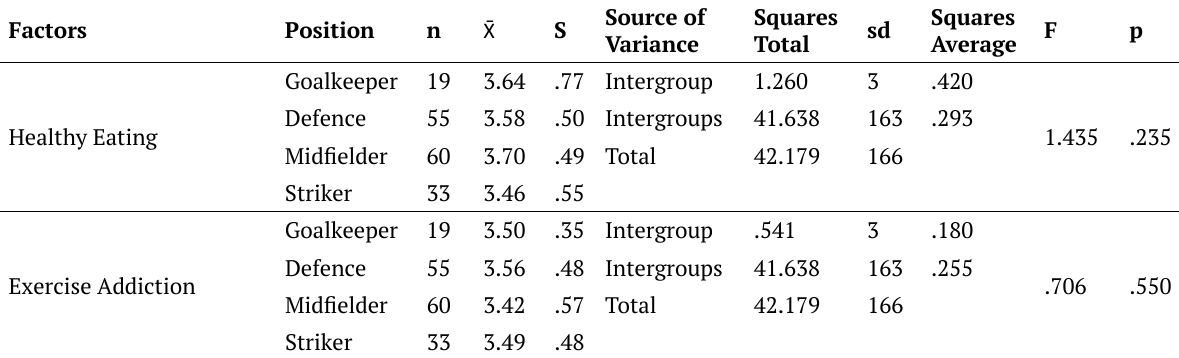
Table 5. ANOVA results based on position of female football players’ attitudes and exercise dependency on healthy eating Factors